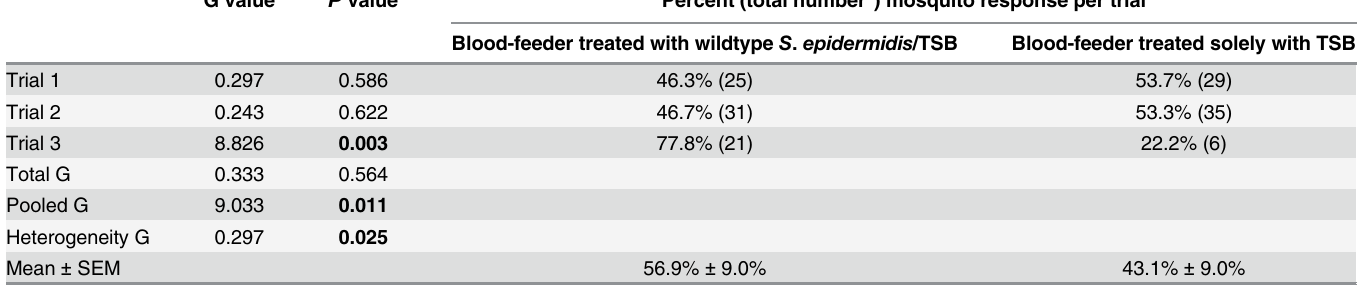
Table 2. Repeated G test of goodness-of-fit test, percent response per trial, and mean percent ± SEM across trials of 5-8-d old Ae . aegypti (N 1 = 3; n 2 = 50) adult female attraction to blood-feeders located on opposite sides of the top of a 82 cm x 45 cm x 52 cm Plexiglas cage during 15-min experiments at 25°C and 80% RH and treated with wildtype S . epidermidis /TSB or solely TSB.